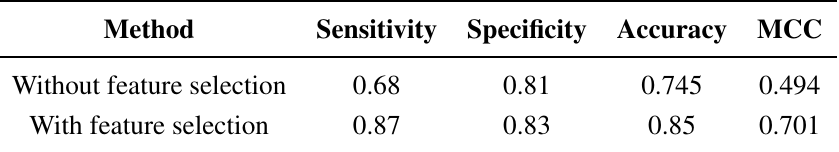
Table 5. Performance of stacking-based ensemble learning method with and without feature